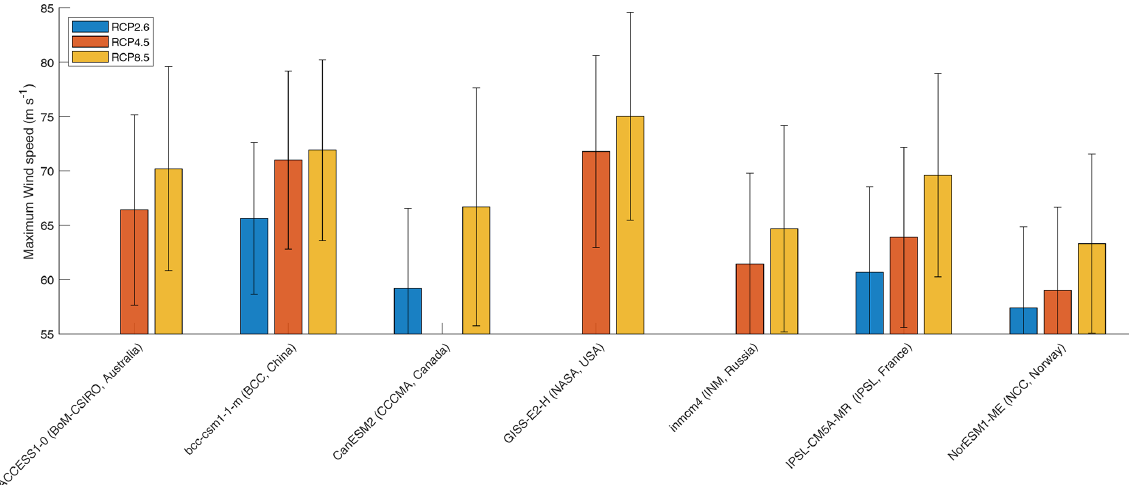
Figure 23. Average and standard deviations of the maximum wind speed of tropical cyclones generated with the CMIP5 models after correction. Table A4 provides the average value of maximum wind speed (ms − 1